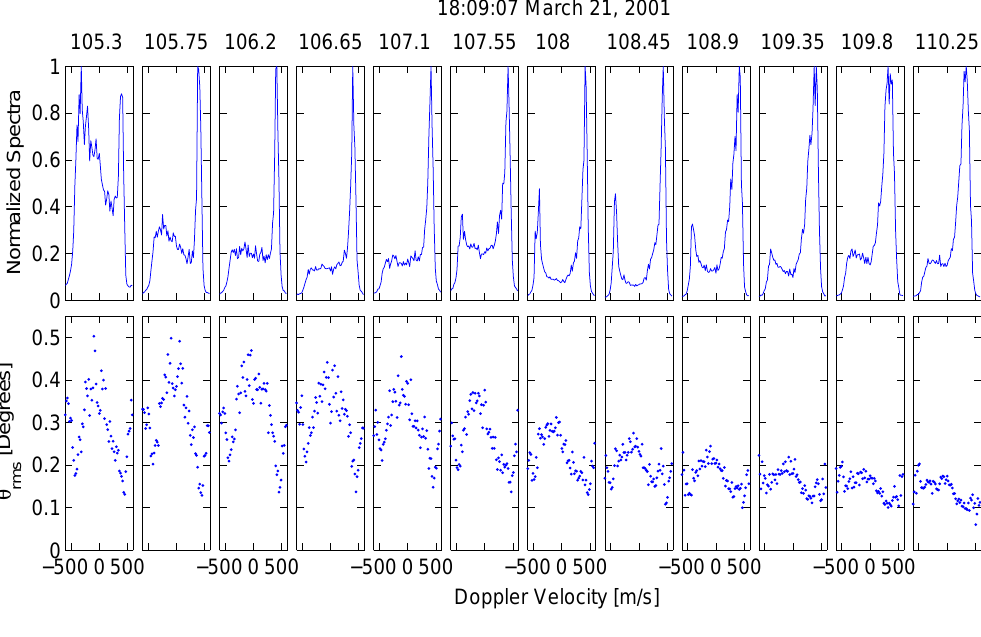
Fig. 11. Type 1 echoes from 105–110km above Jicamarca in 2001. Note the simultaneous presence of both positive and negative peaks at times in the power spectra in the top row. The bottom row shows aspect angle data discussed below (from Lu et al.,